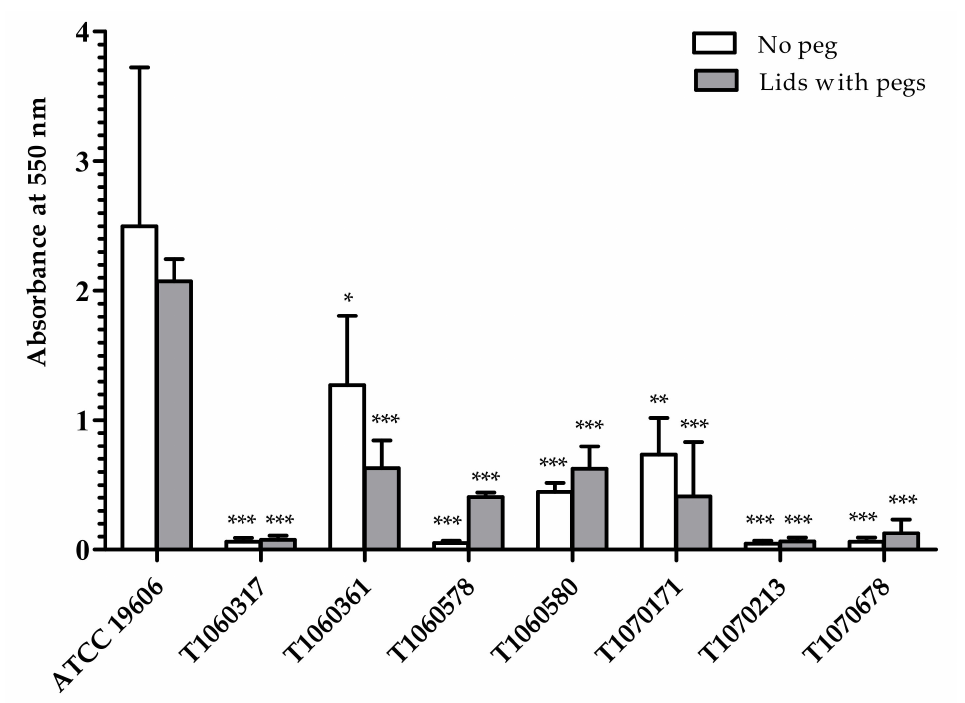
Figure 4. Biofilm formation abilities of the CCR-AB isolates. Individual bacterial suspension was cultured overnight in conventional 96-well plates (‘No peg’; open bars) or in 96-wells with lid pegs (filled bar). Biofilms were measured by crystal violet staining. The ordinate represents measured absorbance at 550 nm. The error bars indicate standard errors from three replicate determinations. Statistical analysis was calculated using one-way ANOVA with Dunnett’s test for comparison to the reference, ATCC 19606. Numbers of asterisks indicate significant difference in different levels with p ≤ 0.001 (***), 0.001 < p ≤ 0.01 (**), and 0.01 < p ≤ 0.05